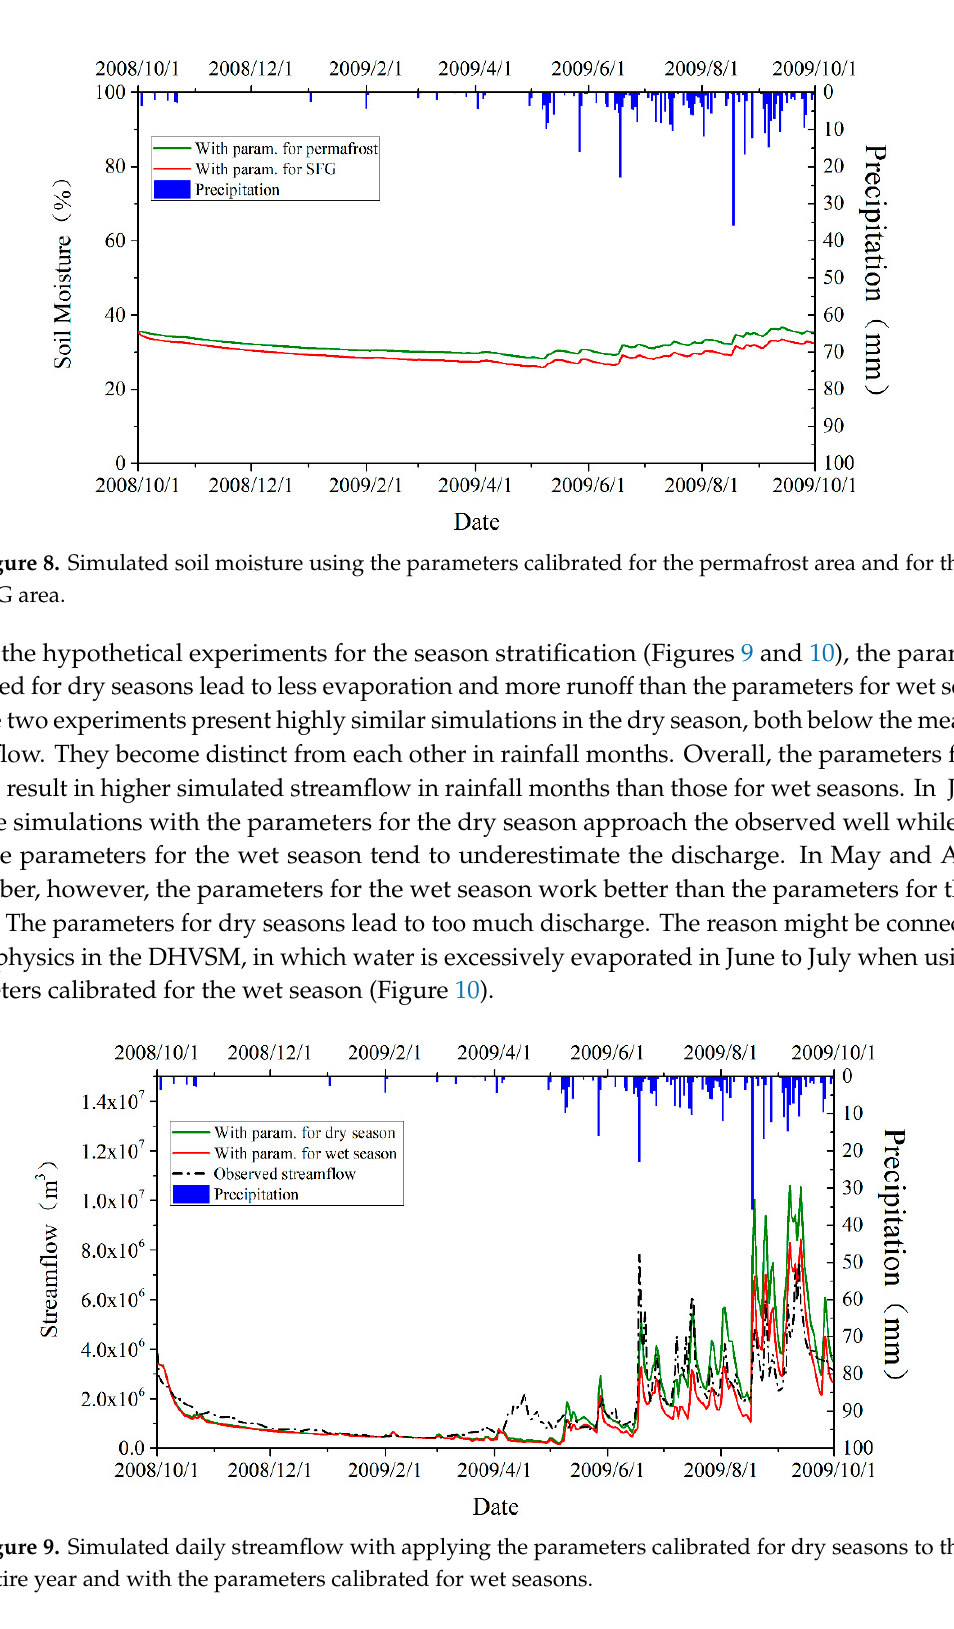
Figure 7. Simulated daily streamflow with experimentally applying the parameters calibrated for the permafrost area to the entire basin and with the parameters for the seasonally frozen ground (SFG) area.